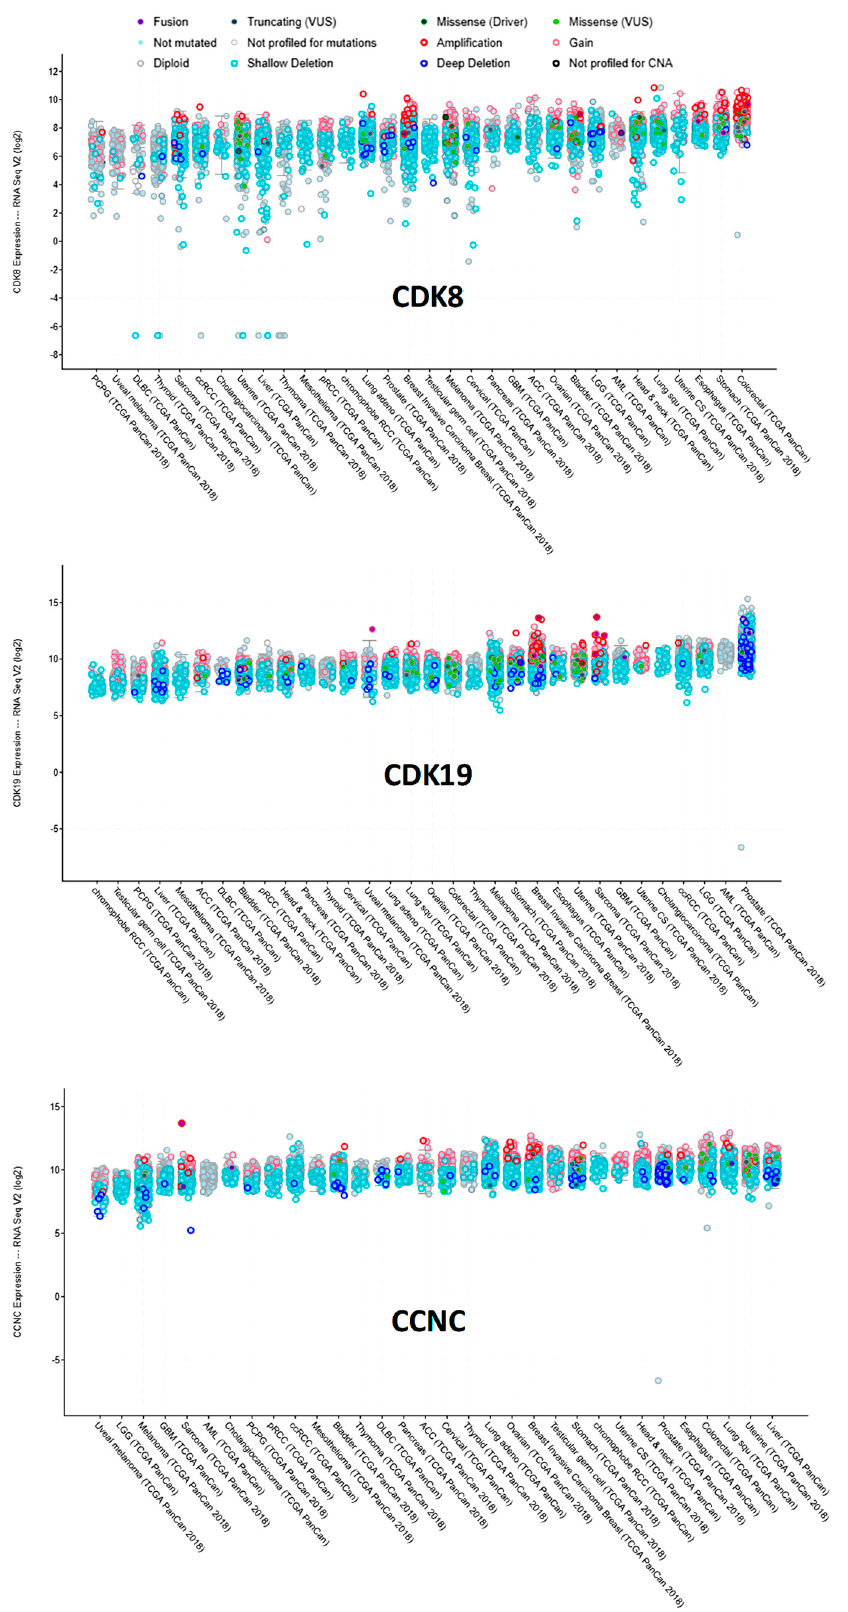
Figure 5. Expression of CDK8/CDK19/CCNC in different tumor types in the TCGA database (cBioPortal), arranged by median. Y -axis: normalized transcripts per million (TPM), log scale.